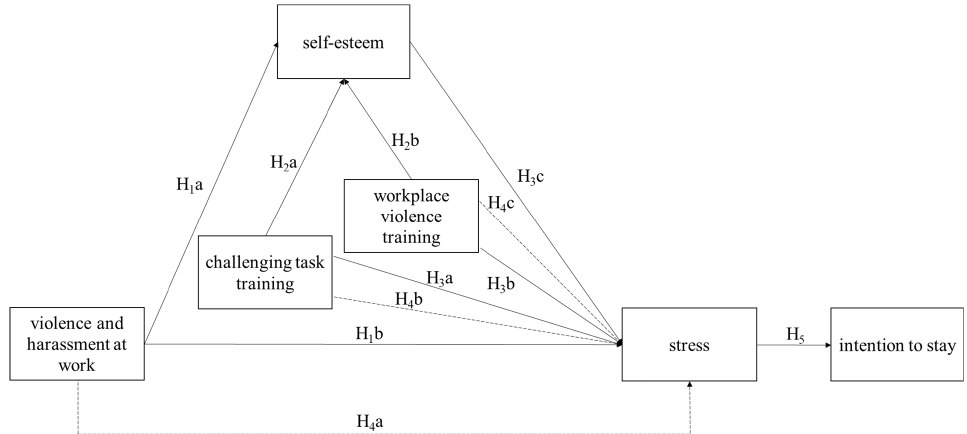
Figure 1. Hypothesized relationships between intention to stay, violence and harassment, challenging task training, workplace violence training, self-esteem, and stress. Notes: Solid lines indicate direct effects; dashes indicate indirect